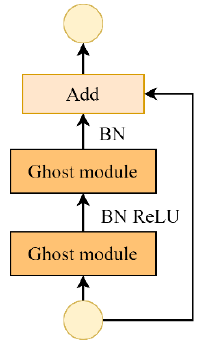
Figure 3. Ghost Figure 3. Ghost bottleneck.